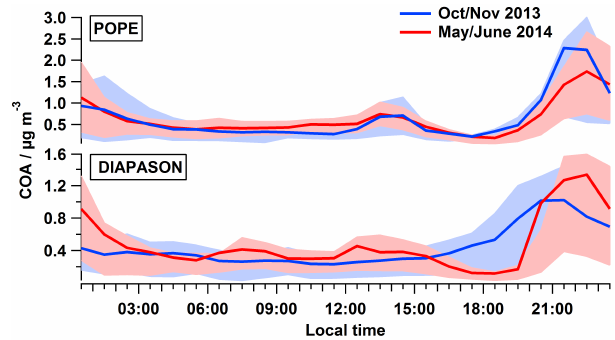
Figure 10. Diurnal cycles of HOA mass concentrations obtained from measurements at Tor Vergata (blue: DIAPASON) and cen- tral Rome (red: POPE) during both seasons. Mean concentrations (traces) and the corresponding 25th and 75th percentiles (shaded areas) are shown.